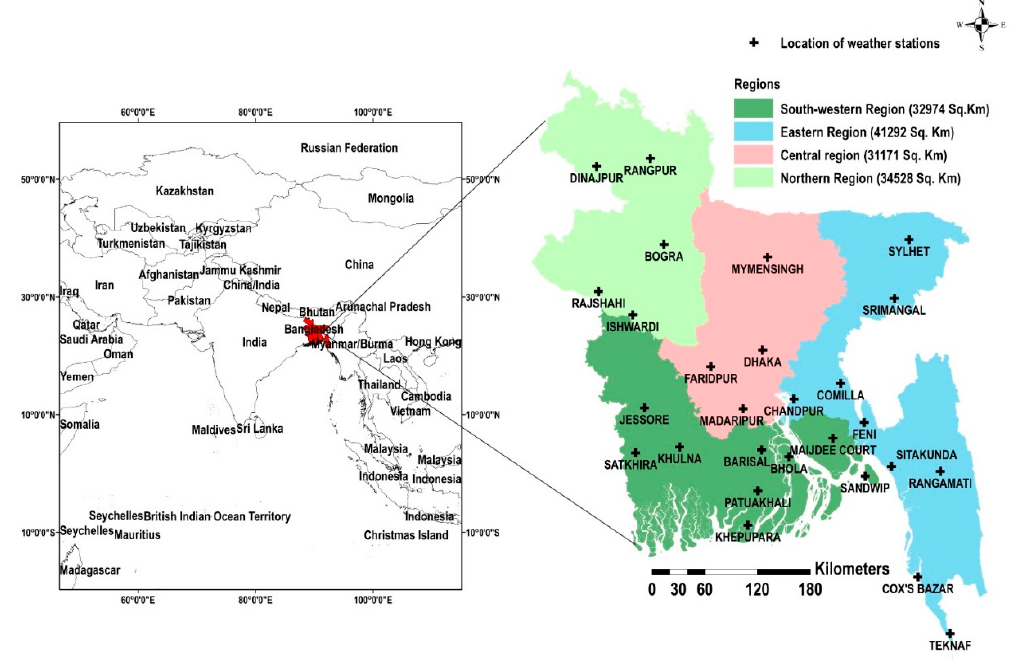
Figure 1. Location of meteorological station and regions in the study area.